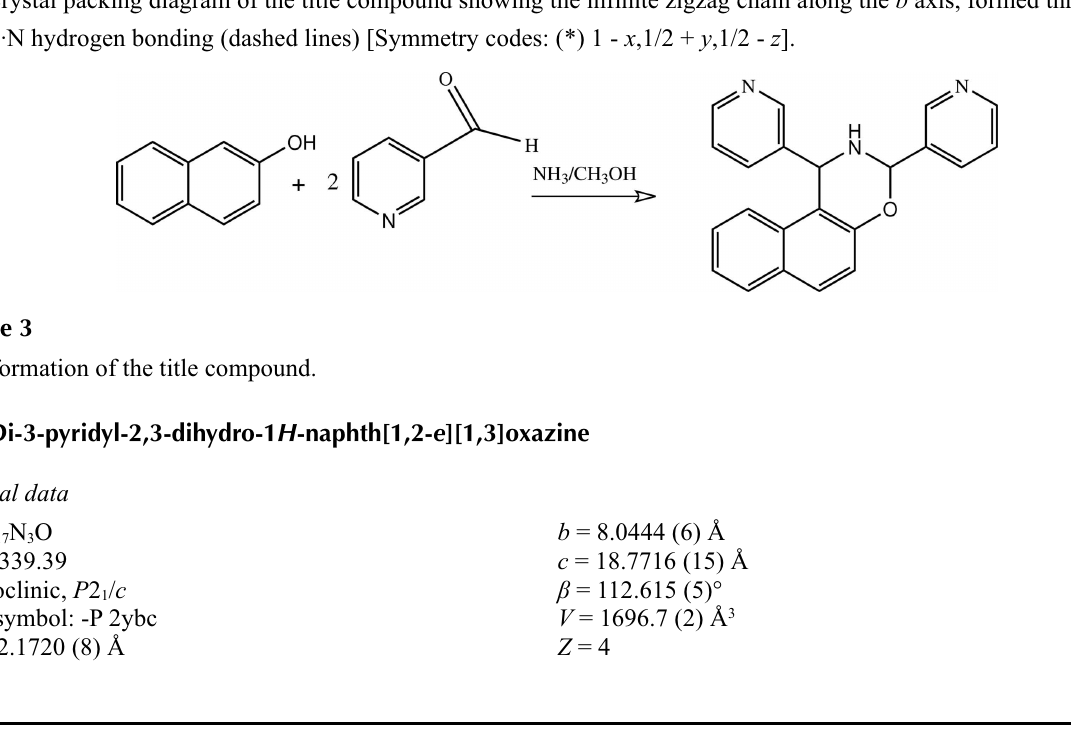
sup-3 Acta Cryst. (2008). E 64 , o573